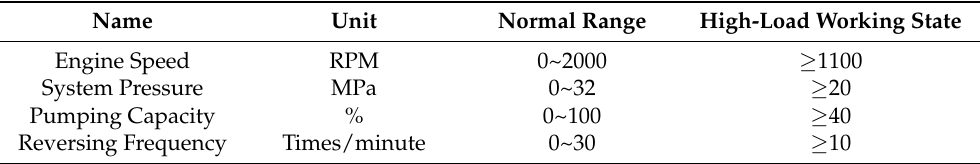
Table 2. Definition table of high-load working state of the concrete pump truck.